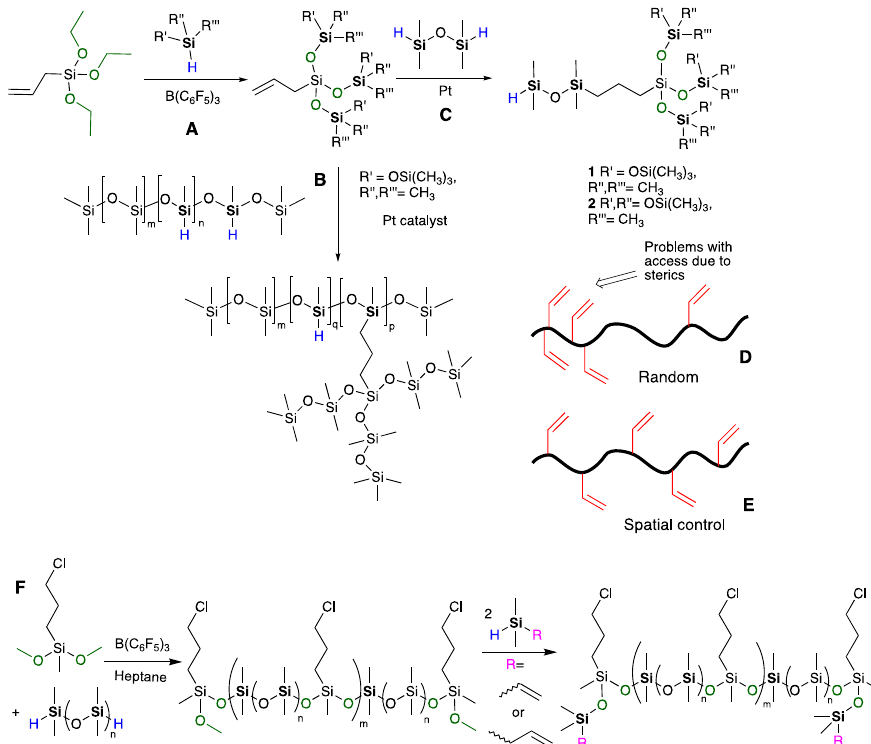
Figure 2. The preparation of ( A , C ): well-defined silicone dendrons via an iterative process [24]. ( B ) Higher branched polymers from random SiH precursors. Model comparison of vinylsilicones with either ( D ) random or ( E ) controlled locations. ( F ) Using the Piers–Rubinsztajn reaction to prepare spatially controlled chloropropylsilicones [26].